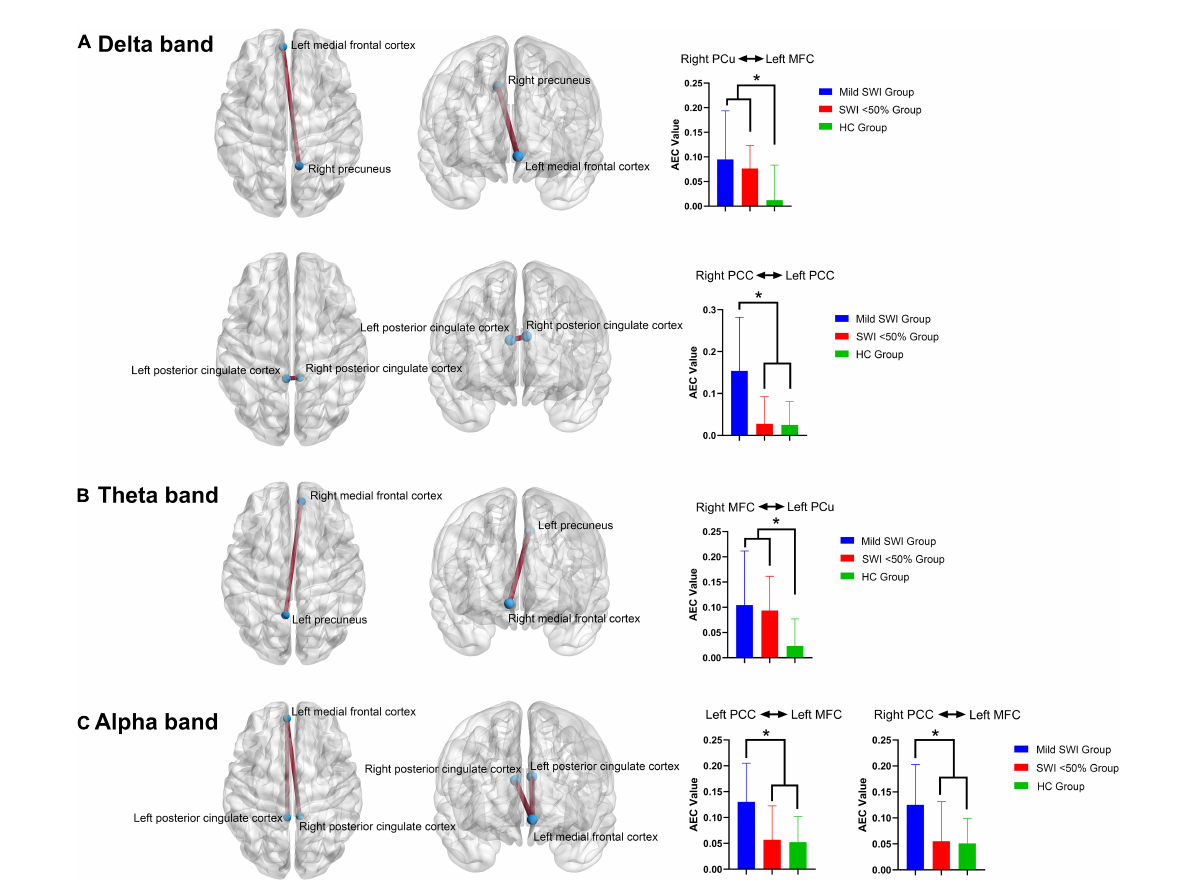
FIGURE2 The significant differences regarding FC between the mild SWI group, SWI < 50% group and HC group. In the delta band (A) , the AEC-c value between the right PCu and left MFC were significantly increased in the mild SWI group and SWI < 50% group, while the AEC-c value between bilateral PCC in the mild SWI group was significantly increased. In the theta band (B) , the AEC-c value between the right MFC and left PCu were significantly increased in the mild SWI group and SWI < 50% group. In the alpha band (C) , the AEC-c value between the left PCC and the left MFC were significantly increased in the mild SWI group, and the AEC-c value between the right PCC and left MFC were significantly increased within the mild SWI group. * P -values after correction were less than